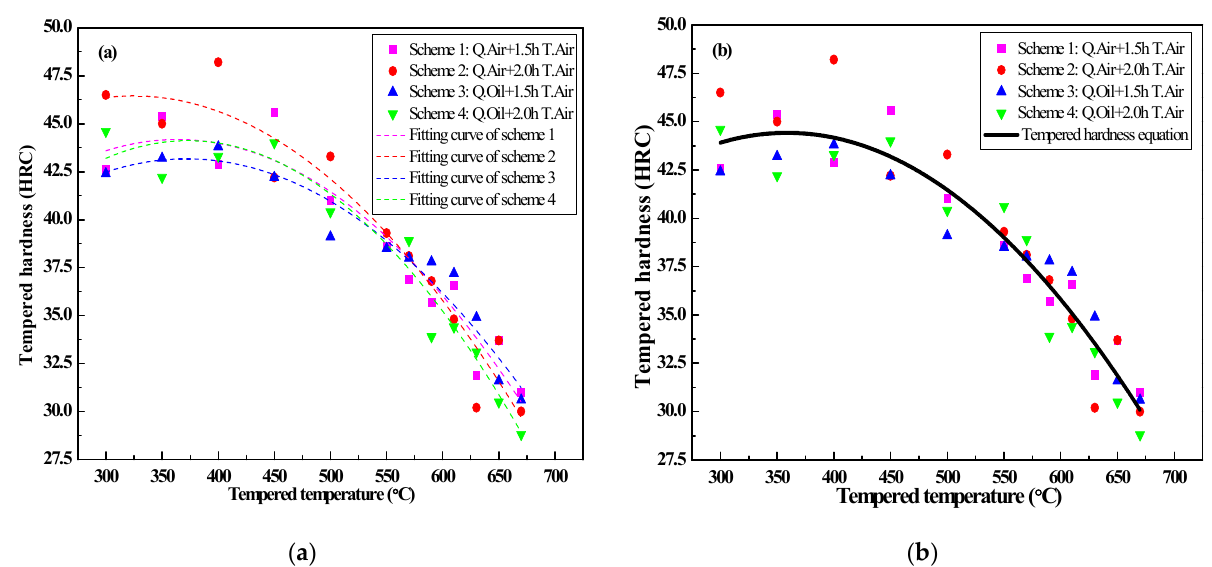
Fitting curve of scheme 1 Fitting curve of scheme 2 Fitting curve of scheme 3 Fitting curve of scheme 4